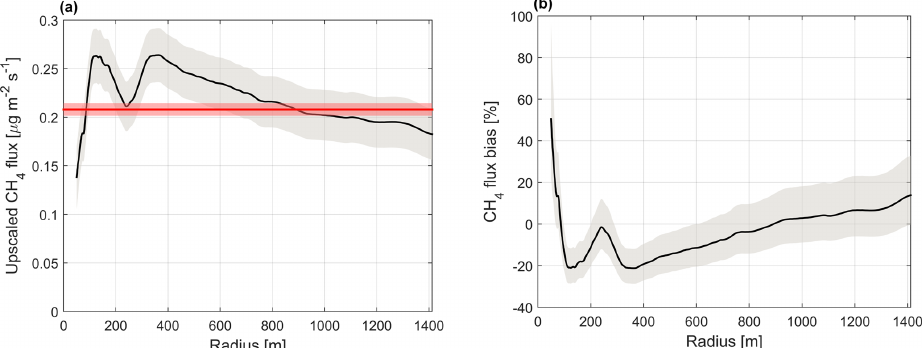
Figure 7. Upscaled CH 4 flux within a circular area as a function of the distance from the EC tower (a) and the corresponding sensor location bias according to Eq. (6) (b) . The red line indicates the mean measured flux. The shaded areas represent the 95% confidence